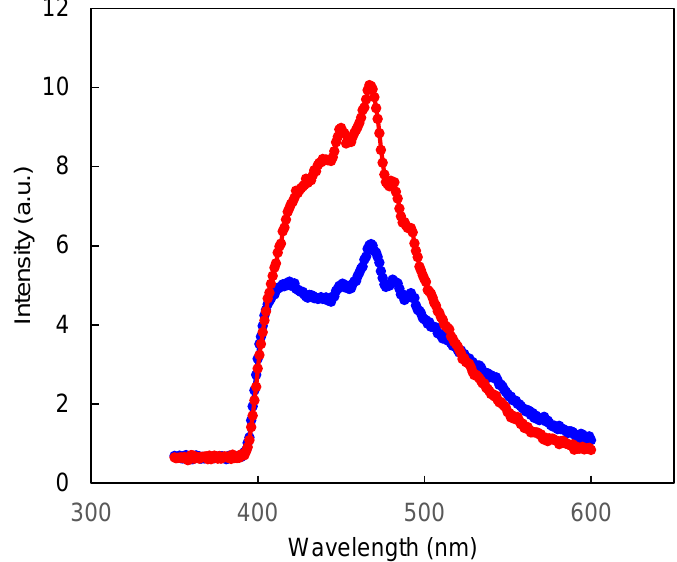
Figure 3. Photoluminescence spectra for TNTs. Calcination temperature: blue line for 300 ◦ C and red line for 500 ◦ C. Since the TNTs were subjected to PL analysis after irradiation, the Rh metal was modified onto the surface of TNTs.